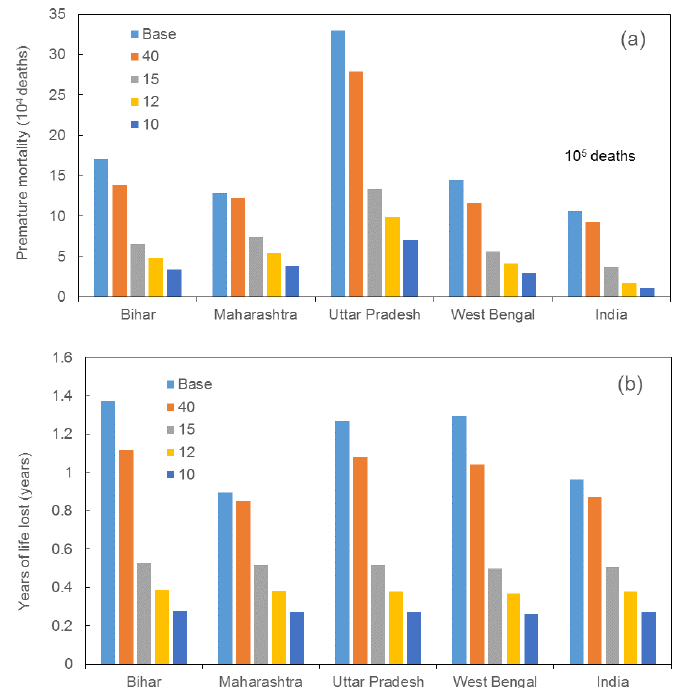
Figure 7. Number of premature deaths (a) and YLL (b) in the whole of India and top PM 2 . 5 -polluted states, Bihar, Maharashtra, Uttar Pradesh (including Delhi), and West Bengal, corresponding to the cases when PM 2 . 5 reduced to 40, 15, 12, and 10µgm − 3 (WHO guideline level). “Base” refers to PM 2 . 5 in